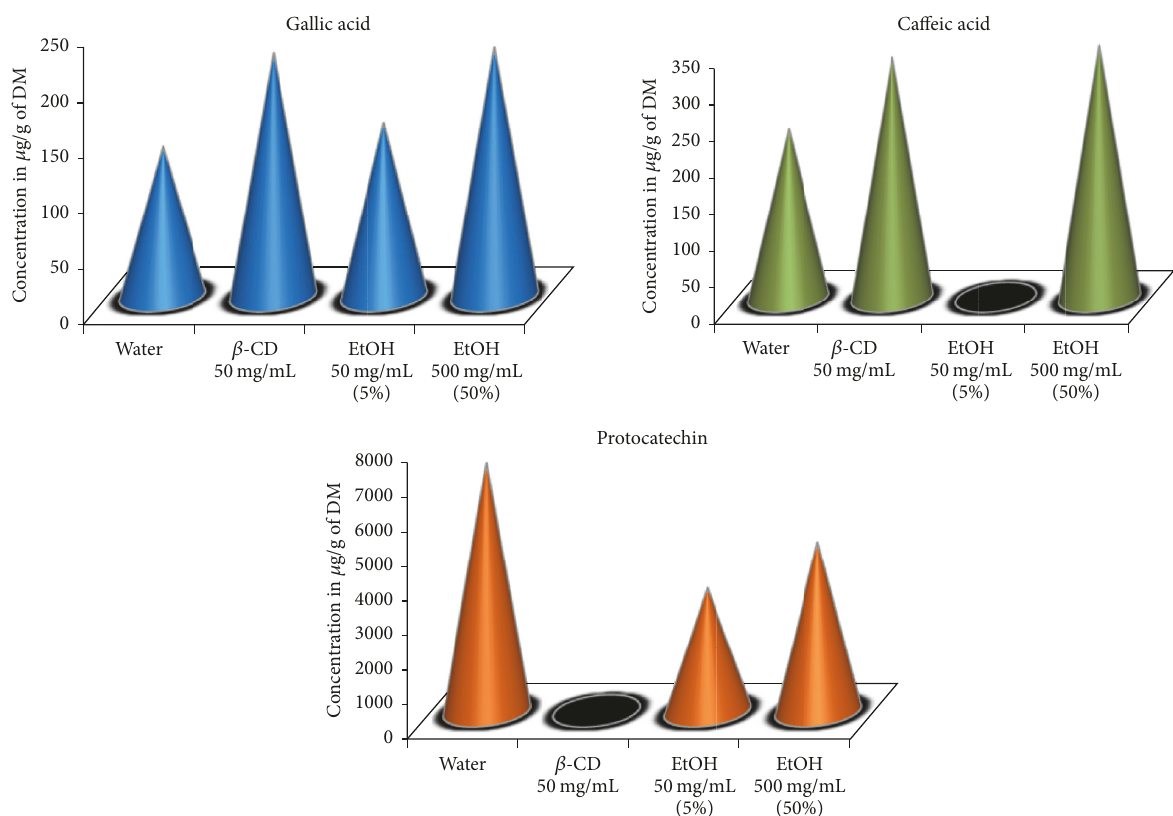
Figure5:Gallicacid,caffeicacid,andprotocatechincontentofwater, 𝛽 -CD(50 mg/mL),EtOH(50mg/mL),andEtOH(500